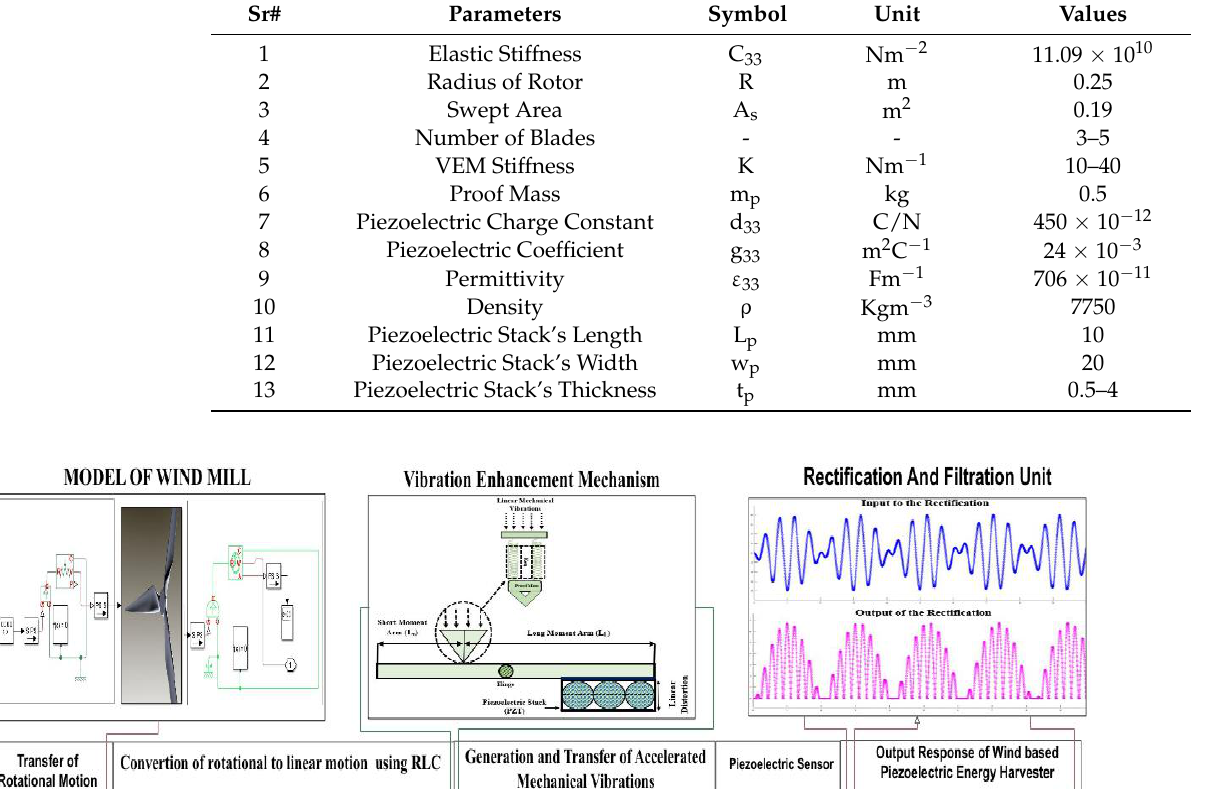
Table 1. Dimensions and properties of the proposed harvester.